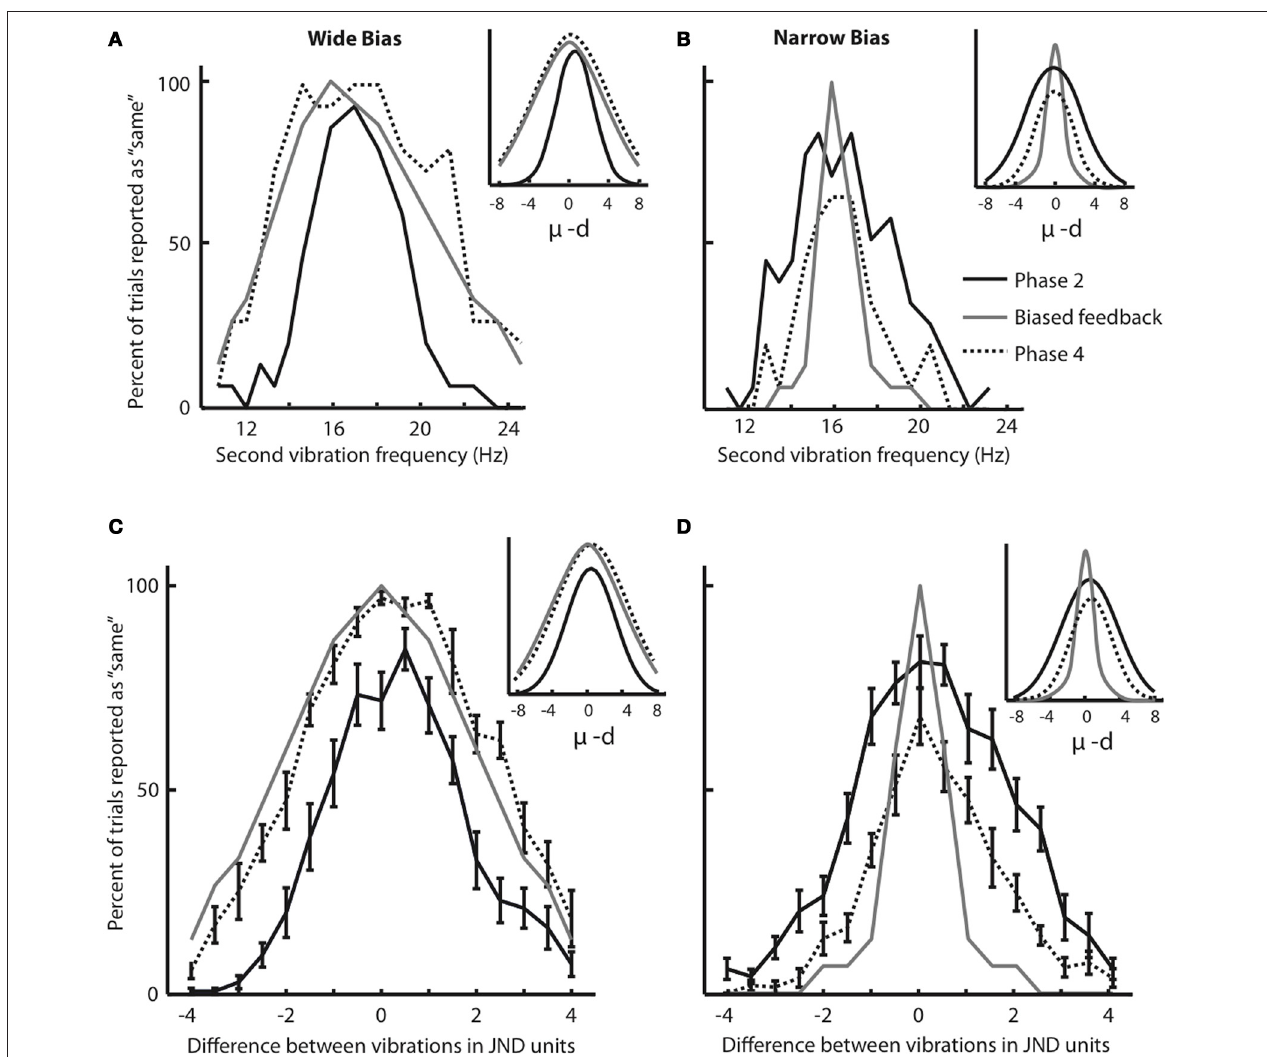
FIGURE 3 | Changes in response distribution caused by feedback. (A) Response distribution (proportion of “same” responses across frequency pairs) for a subject that received Wide feedback. Distribution in Phase 2 (before feedback) is shown in black. The feedback distribution in Phase 3 is shown in light gray. Similar to Figure 1C , the feedback curve illustrates the fraction of trials in which the “same” feedback was provided. The response distribution in Phase 4 (after feedback) is shown by dotted line. Inset illustrates Gaussian functions fitted on the response distributions. (B) Response distribution for a subject that received Narrow feedback. The conventions for the lines are the same as in (A) . Inset illustrates Gaussian functions fitted on the response distributions. Although the subjects in (A) and (B) showed similar distributions in